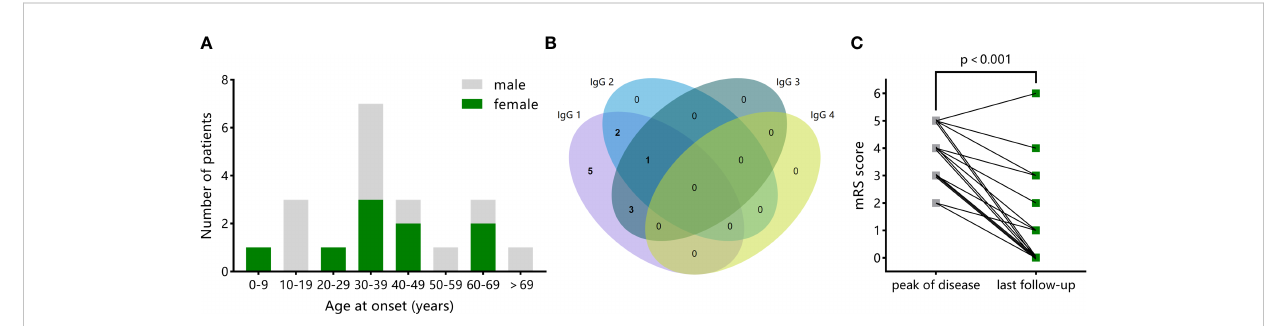
FIGURE 3 Demographics, mGluR5 antibodies subclass distribution, and clinical outcomes in all patients with anti-mGluR5 encephalitis. (A) The distribution of patients by age and sex in anti-mGluR5 encephalitis. (B) Venn diagram of the distribution of IgG subclasses in 11 patients with available information. IgG1 was found in all patients independently (5) or accompanied by IgG2 (2), IgG3 (3), or both IgG2 and IgG3 (1). (C) Comparison of mRS scores at peak of the disease with that at the last follow-up in 16 patients with available